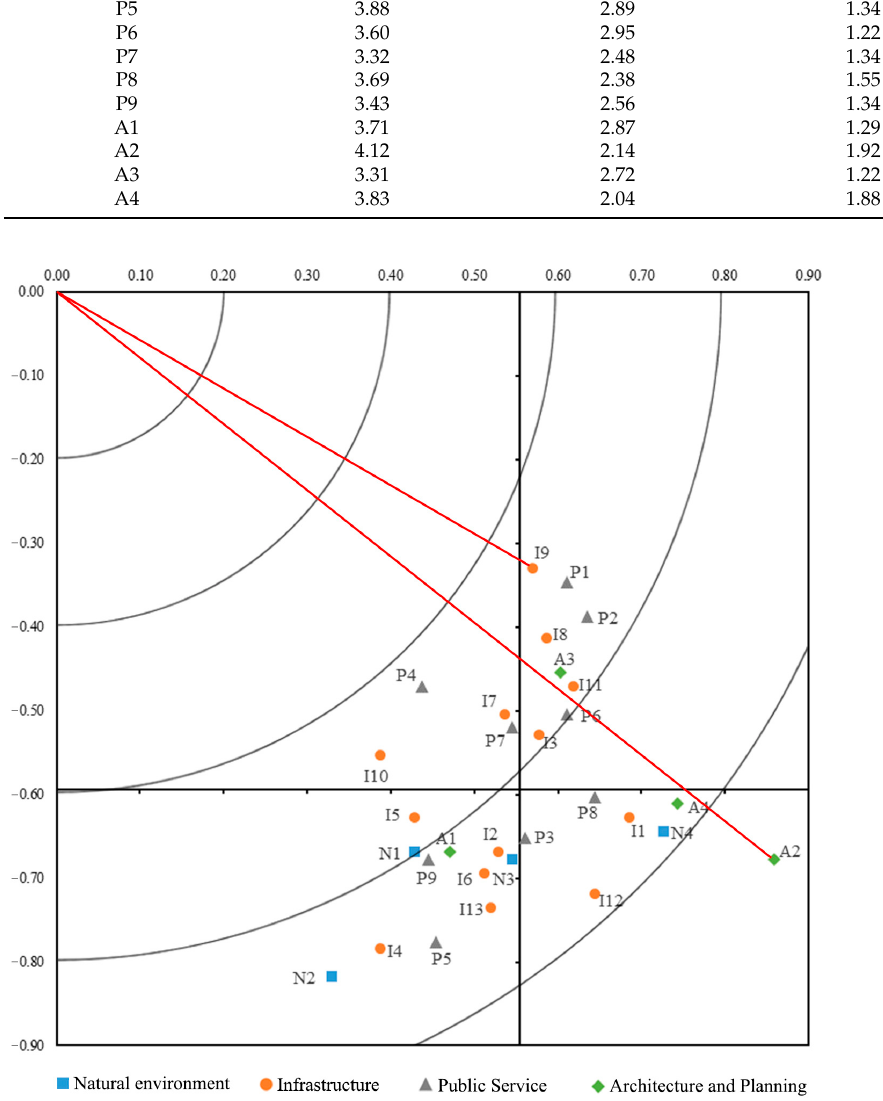
Figure 5. SII–DDI matrix